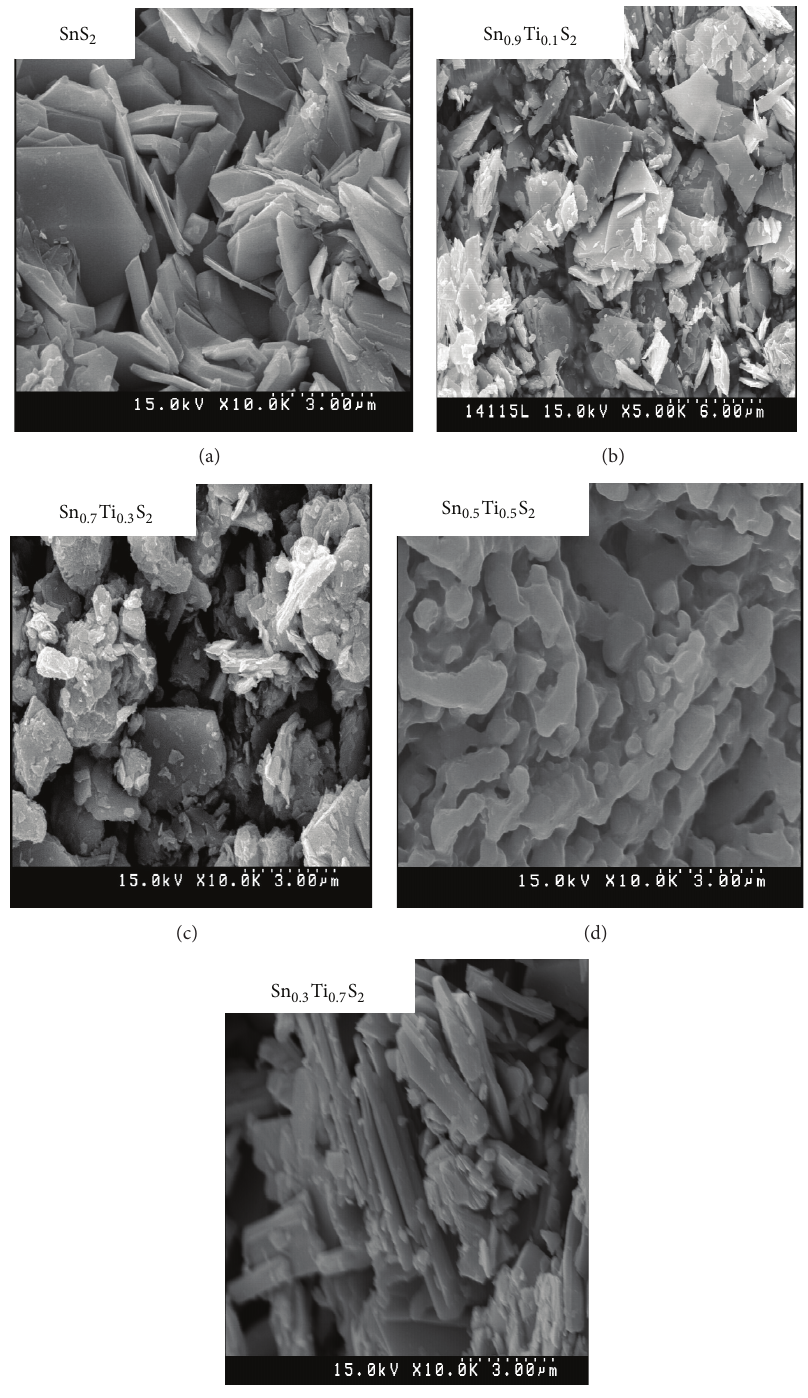
Figure 3: Low-magnification SEM images of the as-synthesized SnS 2 and Sn 1−